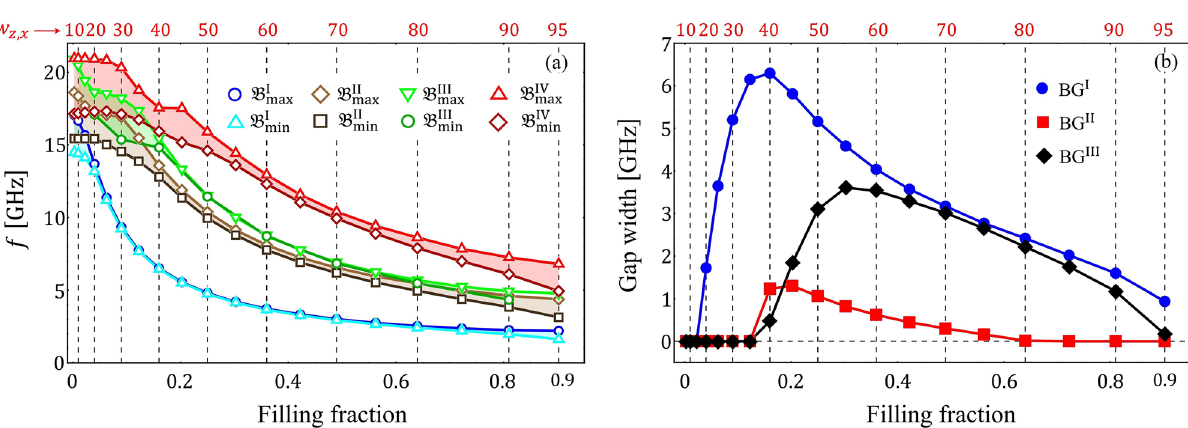
Figure 5. ( a ) Minimum and maximum values for the first four low-frequency bands as a function of the filling fraction. When the difference between the maximum and the minimum becomes negligible, tha band becomes nearly flat. The case w z = w x = 50 nm, a z = a x = 100 nm and D = 3 mJ/m 2 is considered. ( b ) Bandgap widths of the first three bandgaps, calculated in the reduced Brillouin zone, are depicted as a function of the filling